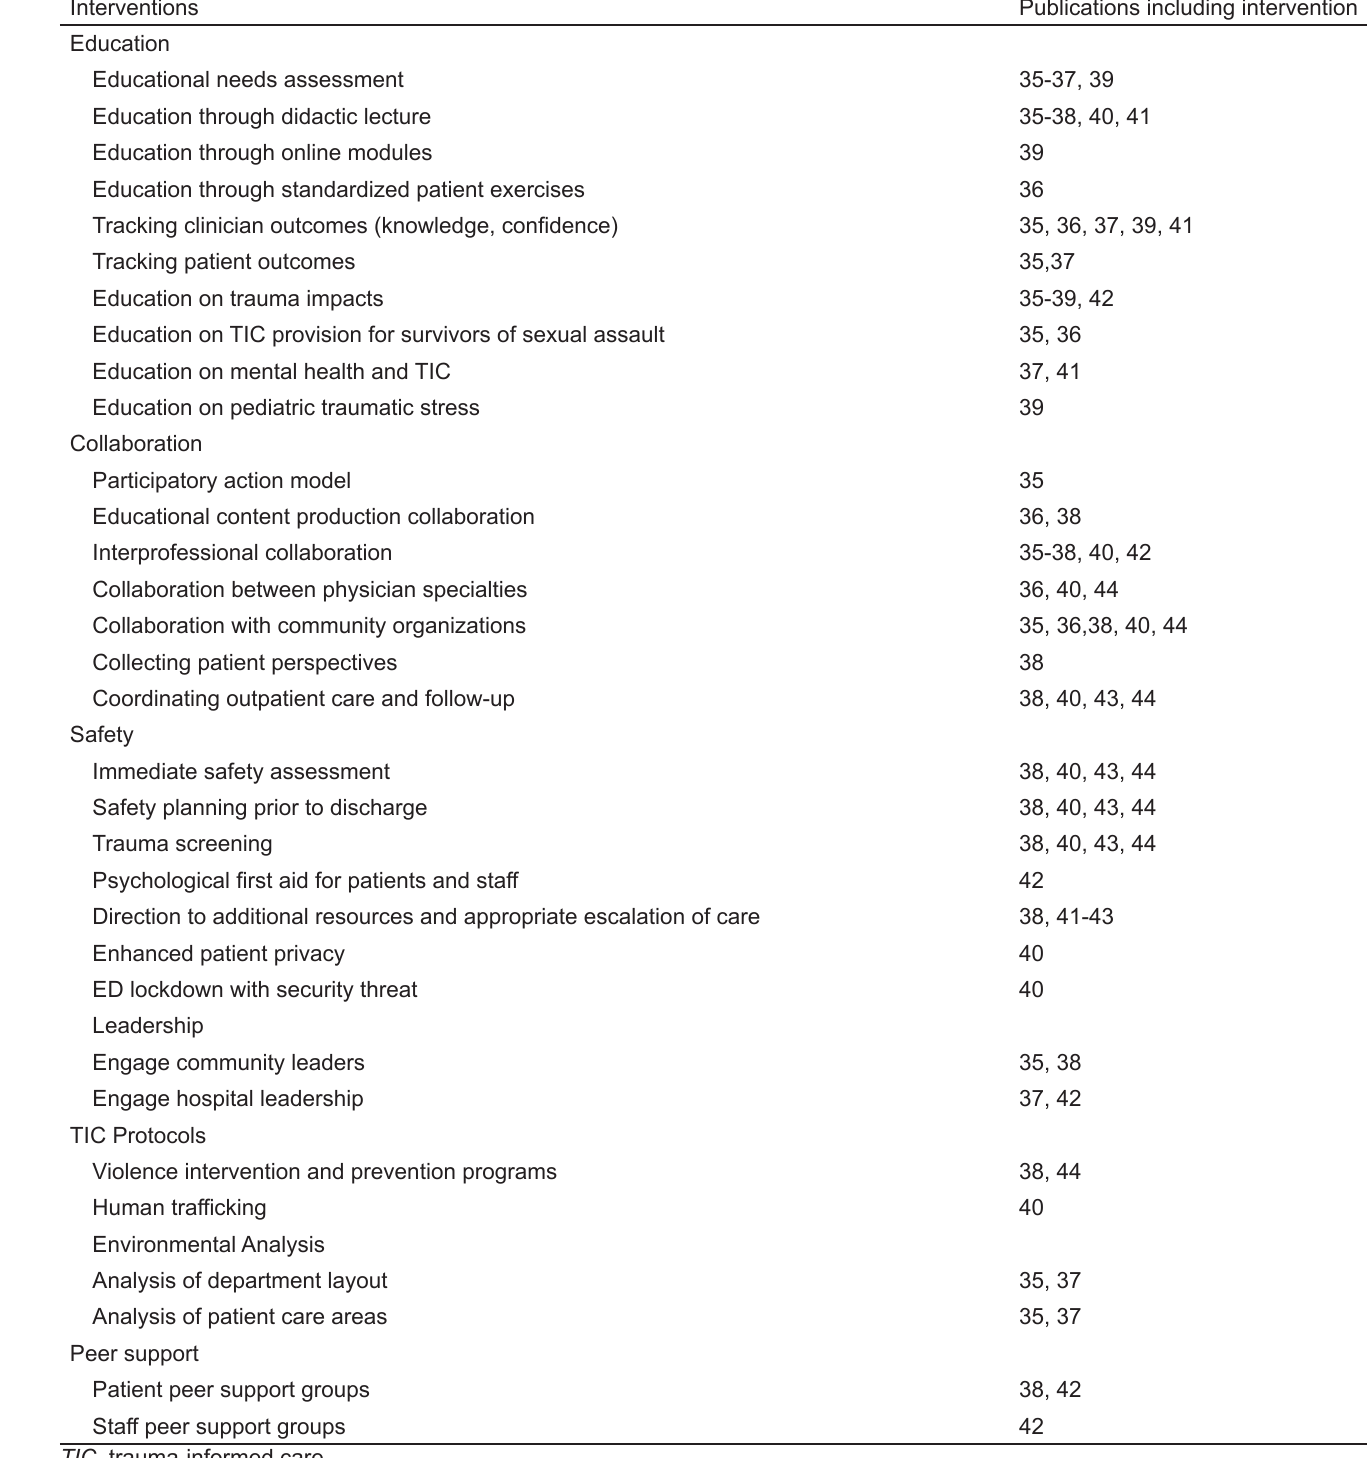
Table 3. Unique trauma-informed care interventions by